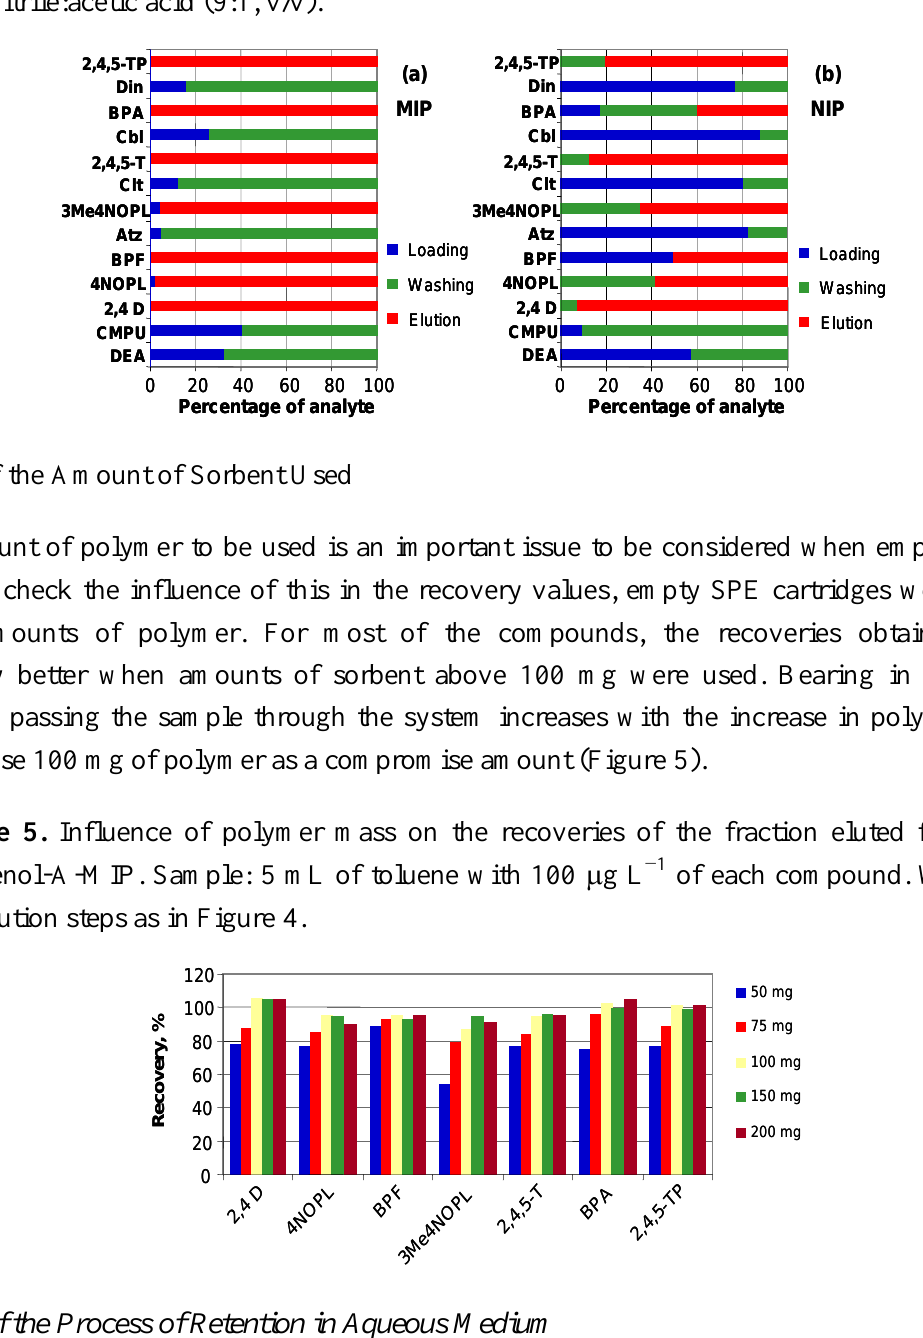
Figure 4. Percentage of each of the compounds studied in the loading, washing and elution steps of the ( a ) MIP and ( b ) NIP. Sample: 5 mL of toluene spiked at a concentration of 100  g L −1 . Washing step: 10 mL of dichloromethane. Elution step: 10 mL of acetonitrile:acetic acid (9:1, v/v).